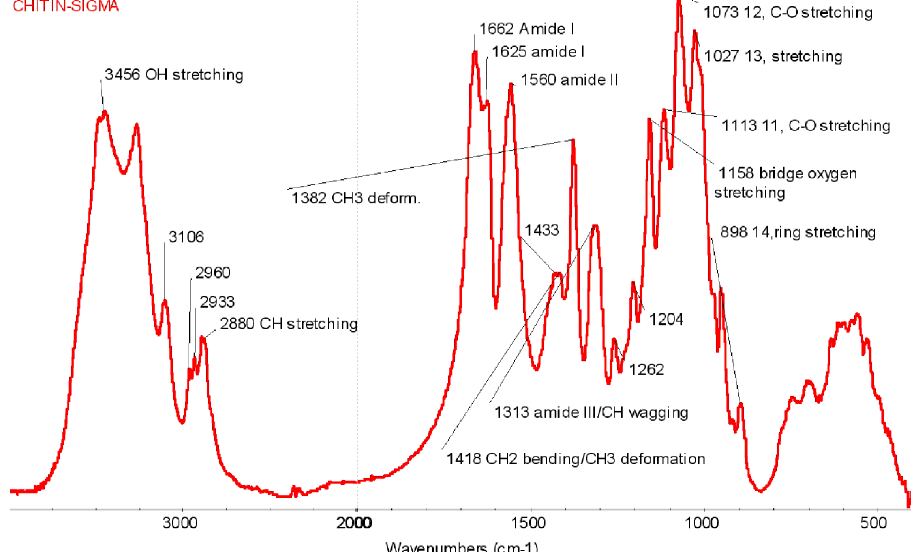
Fig. 2 IR spectra of chitin Sigma with assignments of the bands (note: amide I ¹ valence vibration C=O conjugated with NH deformation, amide II ¹ > N-H deformation vibration, amide III ¹ C-N- valence